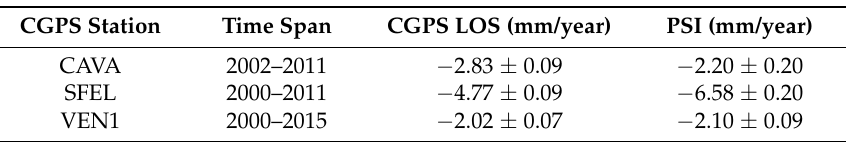
Table 1. Comparison between CGPS and representative calibrated PSI average velocities obtained by TerraSAR-X (see Figure 1b–d).